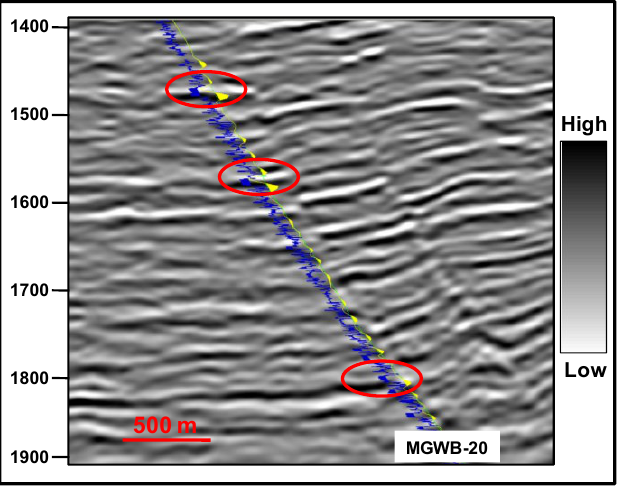
Figure 3: Well to seismic tie shows troughs correspond to sand and peaks correspond to shale